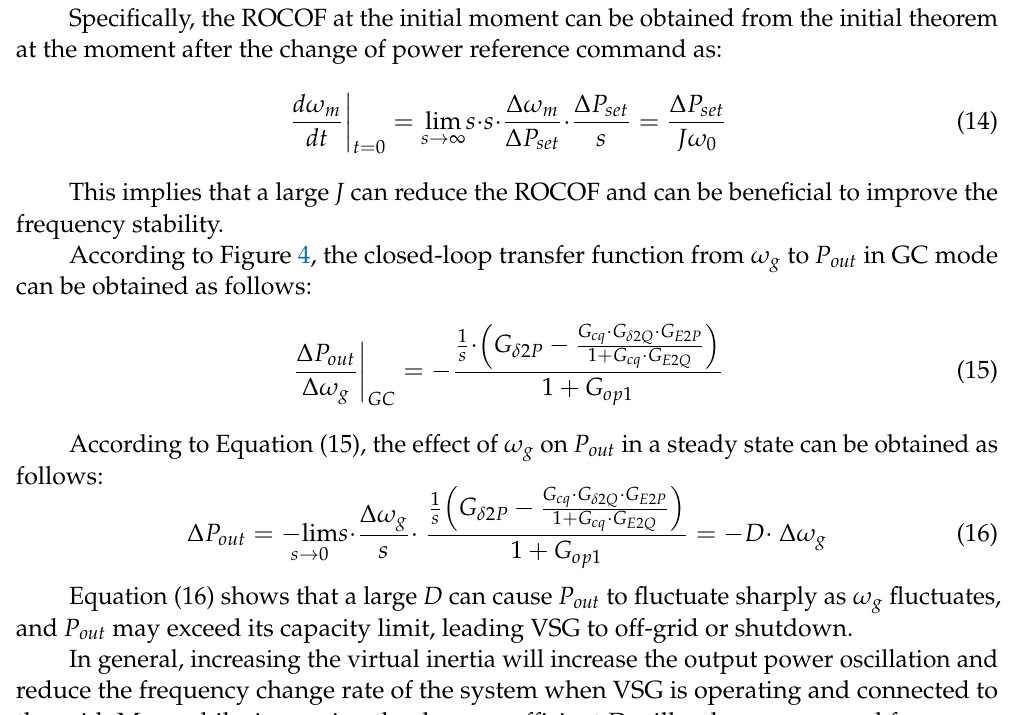
Figure 7. Frequency response curve under different J and D. ( a ) different J ( b ) different D